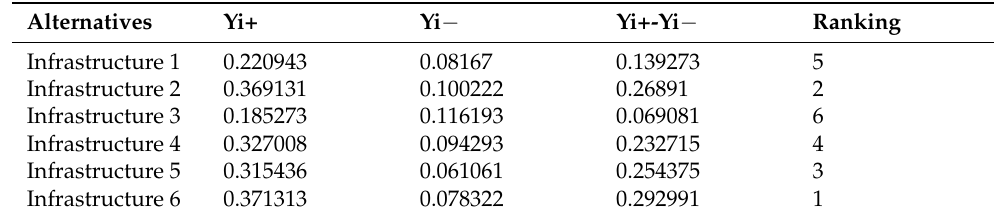
Table 9. Ranking of the